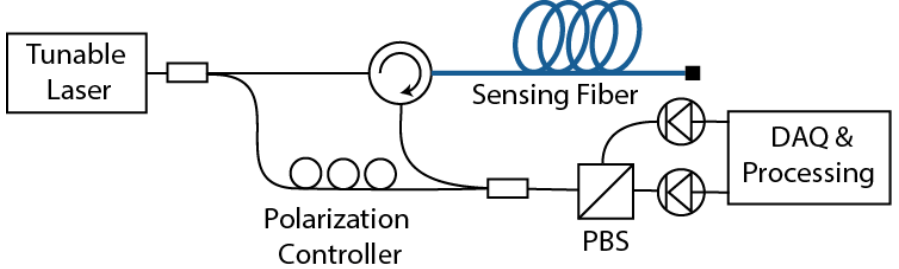
Figure 2. Schematic of a conventional optical frequency-domain reflectometry (OFDR) system implementation.